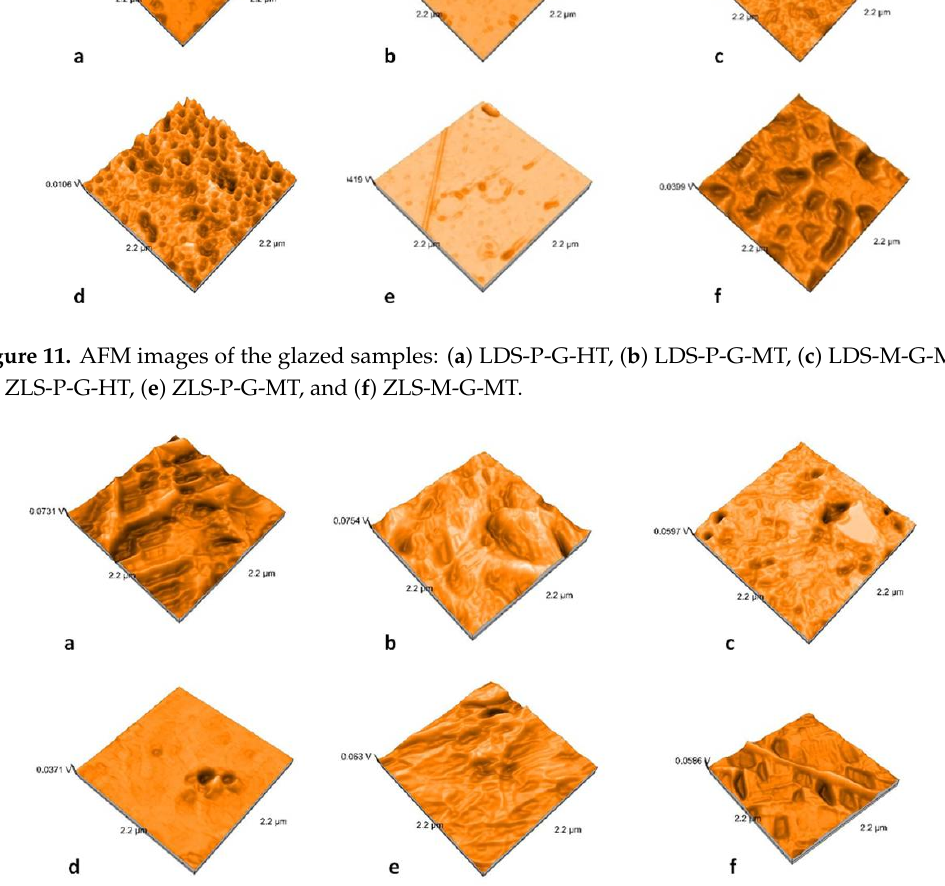
Figure 12. AFM images of the polished samples after thermocycling: ( a ) LDS-P-P-HT, ( b ) LDS-P-P-MT, ( c ) LDS-M-P-MT, ( d ) ZLS-P-P-HT, ( e ) ZLS-P-P-MT, and ( f ) ZLS-M-P-MT.